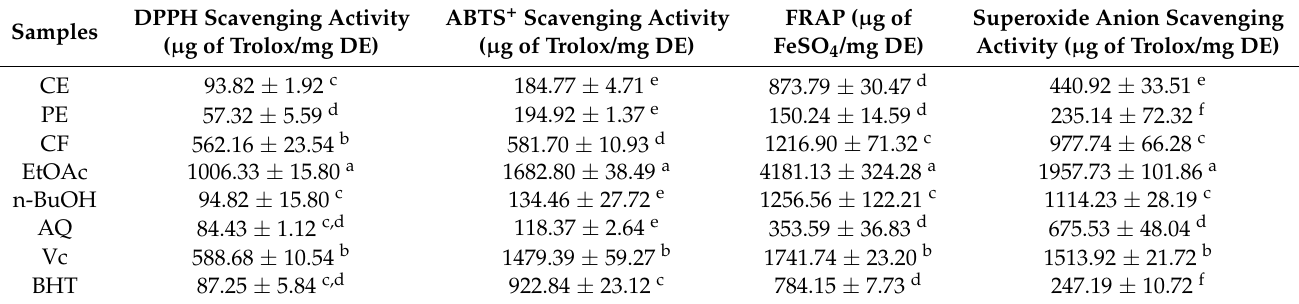
Table 2. The antioxidant activities of the P. frutescens leaf extract and its